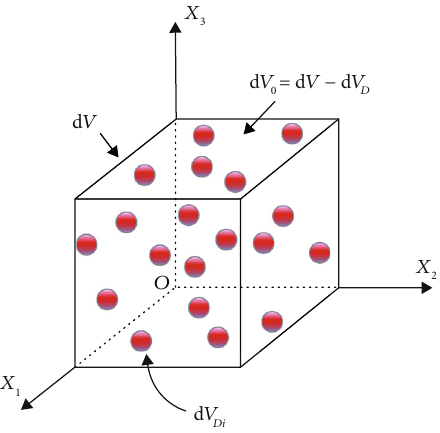
Figure 3: Distribution diagram of the matrix and damaged body in the unit